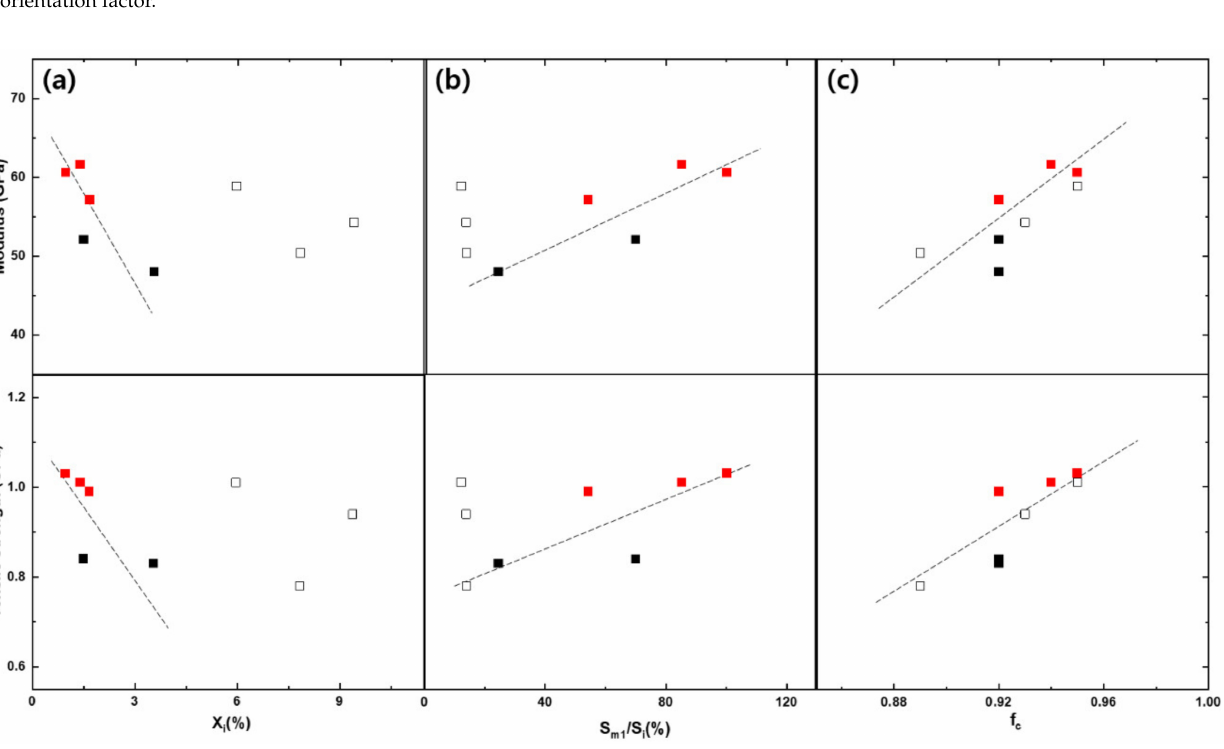
Figure 9. Relationship between the mechanical properties and the structural data (( a ) the fraction of non-crystalline isotropic phase ( X i ), ( b ) area ratio ( S m1 / S i ) and ( c ) crystalline orientation factor ( f c )) analyzed from the 2D-WAXD patterns of the as-spun fibers ( (cid:4) : L-50K/70K-10, (cid:3) : L-30K/50K/70K-20, (cid:4) :